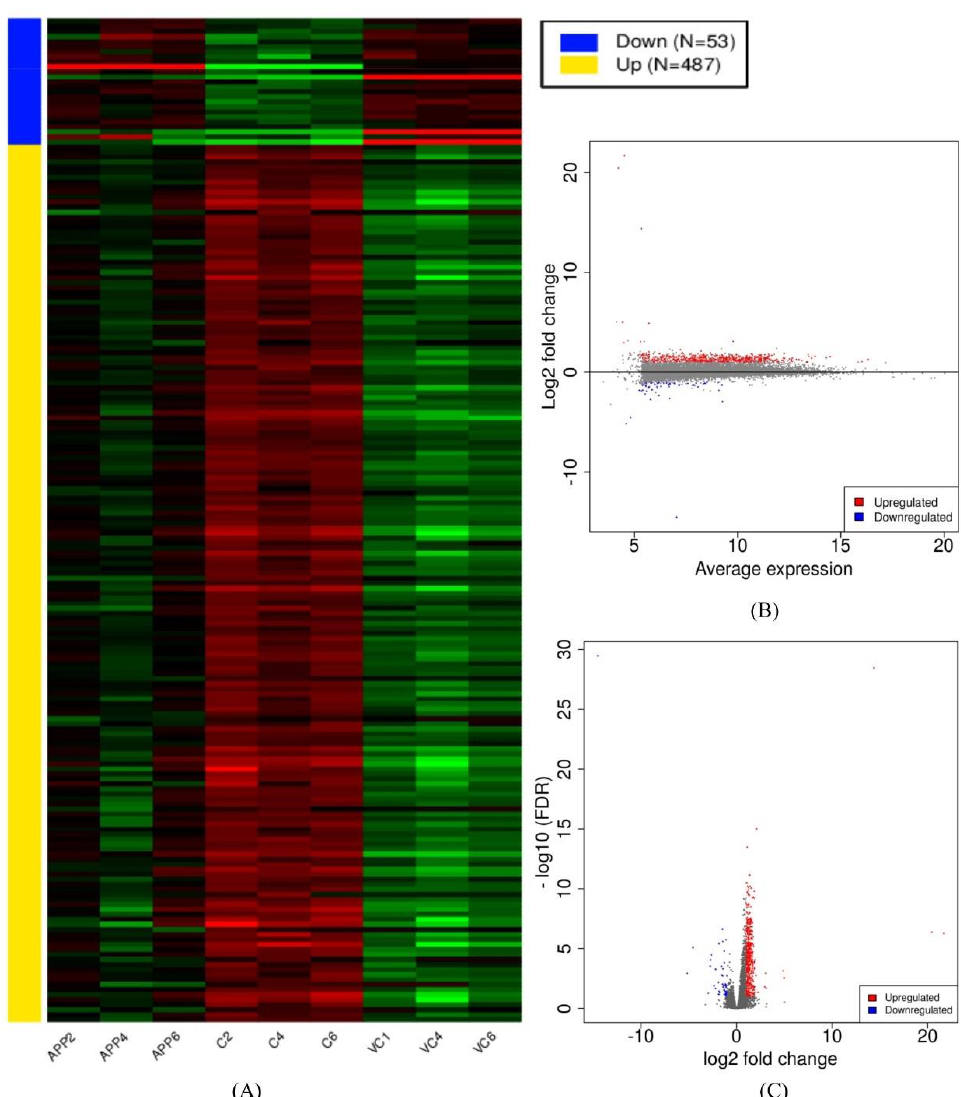
Figure 2. ( A ) Heatmap, ( B ) MA, and ( C ) volcano plots of differentially expressed genes (DEGs) in comparison of ADM mice+C3G vs. ADM